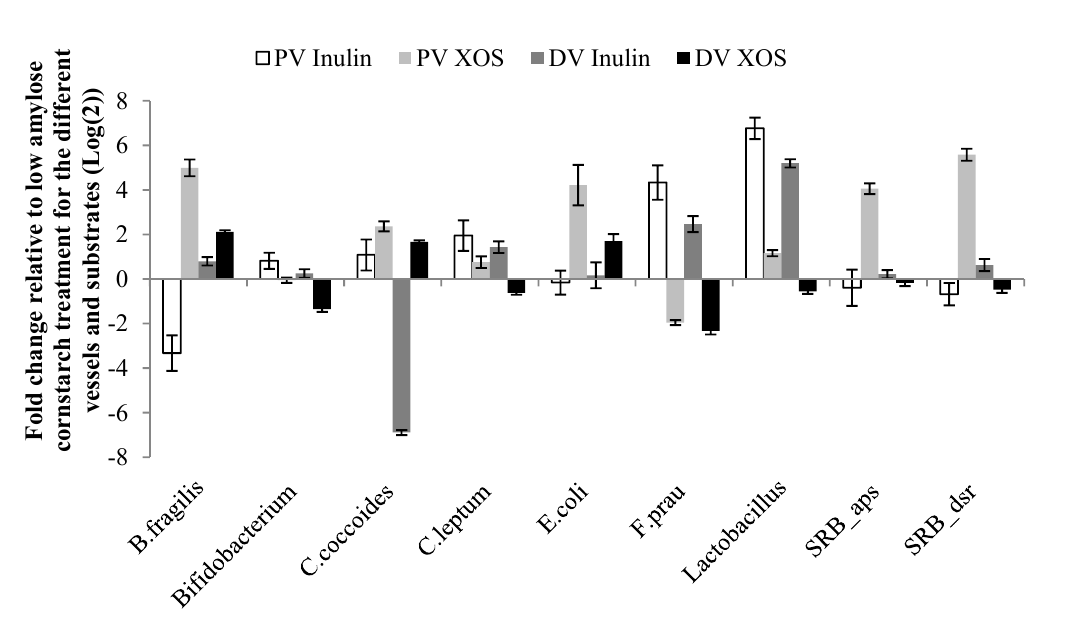
Figure 1. Microbial response to changes in carbohydrate source in a human colonic simulator. Changes are presented as fold change (mean ± SEM) relative to low amylose cornstarch treatment for the two vessels and inulin or XOS, respectively. PV: proximal vessel;